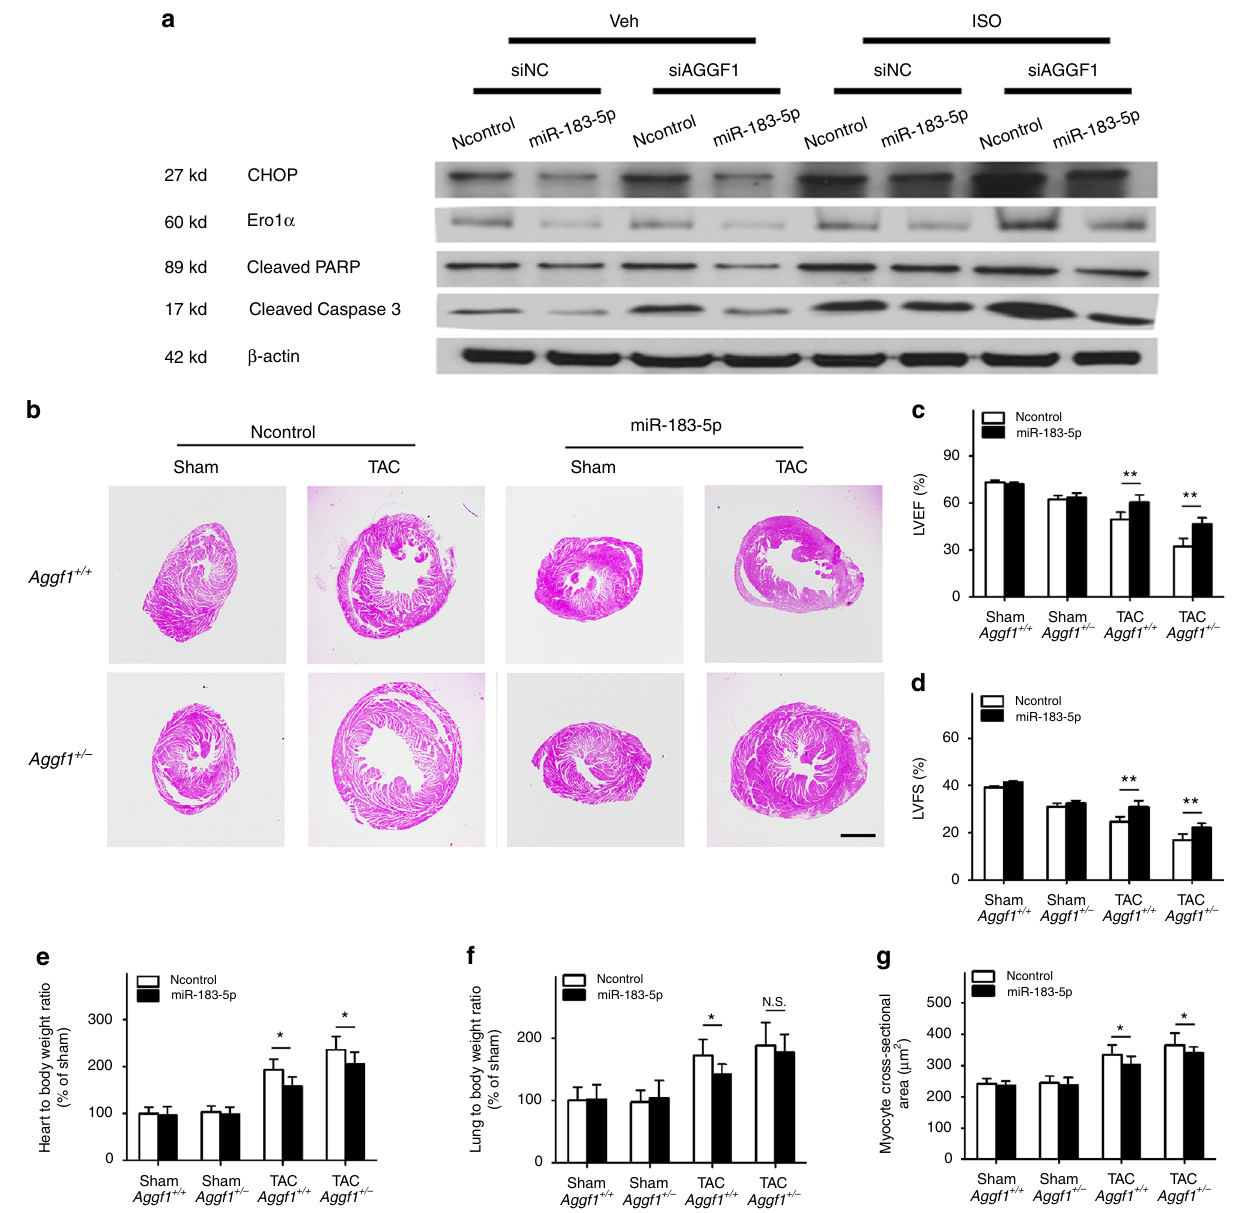
Fig. 7 AGGF1 regulates ER stress and hypertrophy upstream of miR-183-5p. a Representative western blot images for ER stress signaling and apoptotic markers in H9C2 cells treated with ISO to induce hypertrophy or control vehicle (Veh) as well as siAGGF1 or siNC. The experiment was repeated three times. b – g Ago-miR-183-5p inhibits cardiac hypertrophy and improves cardiac function. b H&E staining images of heart sections. Scale bar , 1 mm. c LVEF. d LVFS. e Ratio of heart weight to body weight. f Ratio of lung weight to body weight. g Cross-sectional diameter ( µ m) of cardiomyocytes ( n = 10/group, * P < 0.05, ** P < 0.01, N.S. , Non-signi fi cant). Data are shown as the mean ± s.d. from at least three independent experiments.